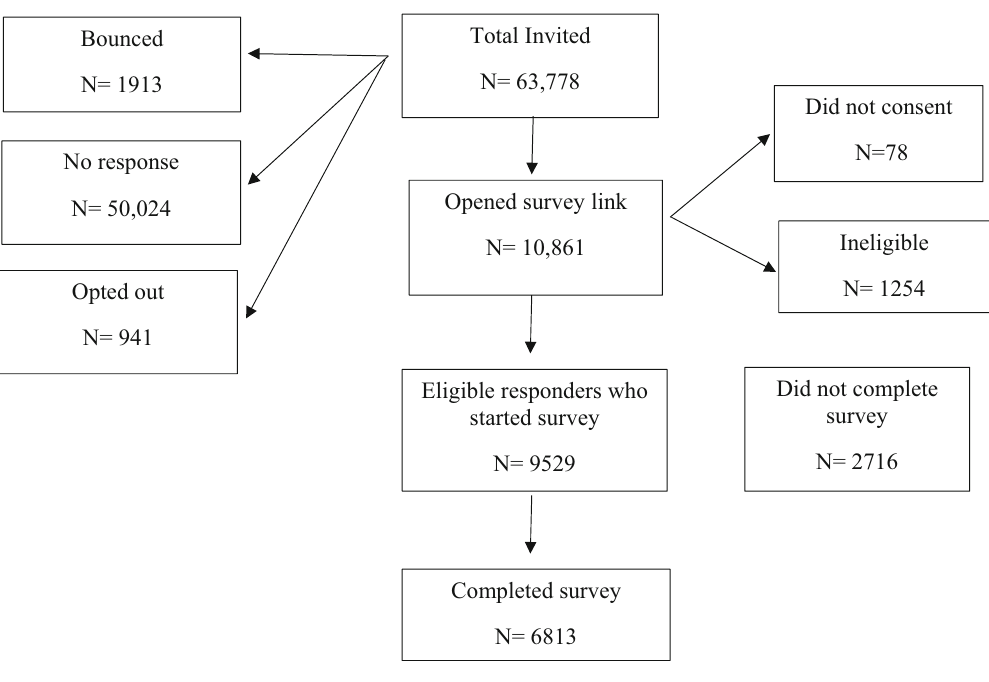
Figure 1. Flow chart of the